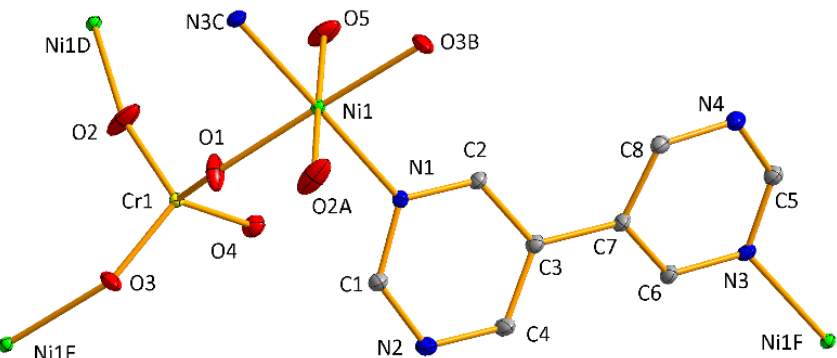
Figure 1. The coordination environments of compound 1 . The H atoms have been omitted for clarity. (Symmetry code: ( A ) 1 − x, − 0.5 + y, 2 − z; ( B ) 1 + x, y, z; ( C ) x, y, 1 + z; ( D ) 1 − x, − 0.5 + y, 2 − z; ( E ) 1 + x, y, z; ( F ) x, y, − 1 + z). A – E refer symmetrical cords of atom in Figure 1, which are labled as